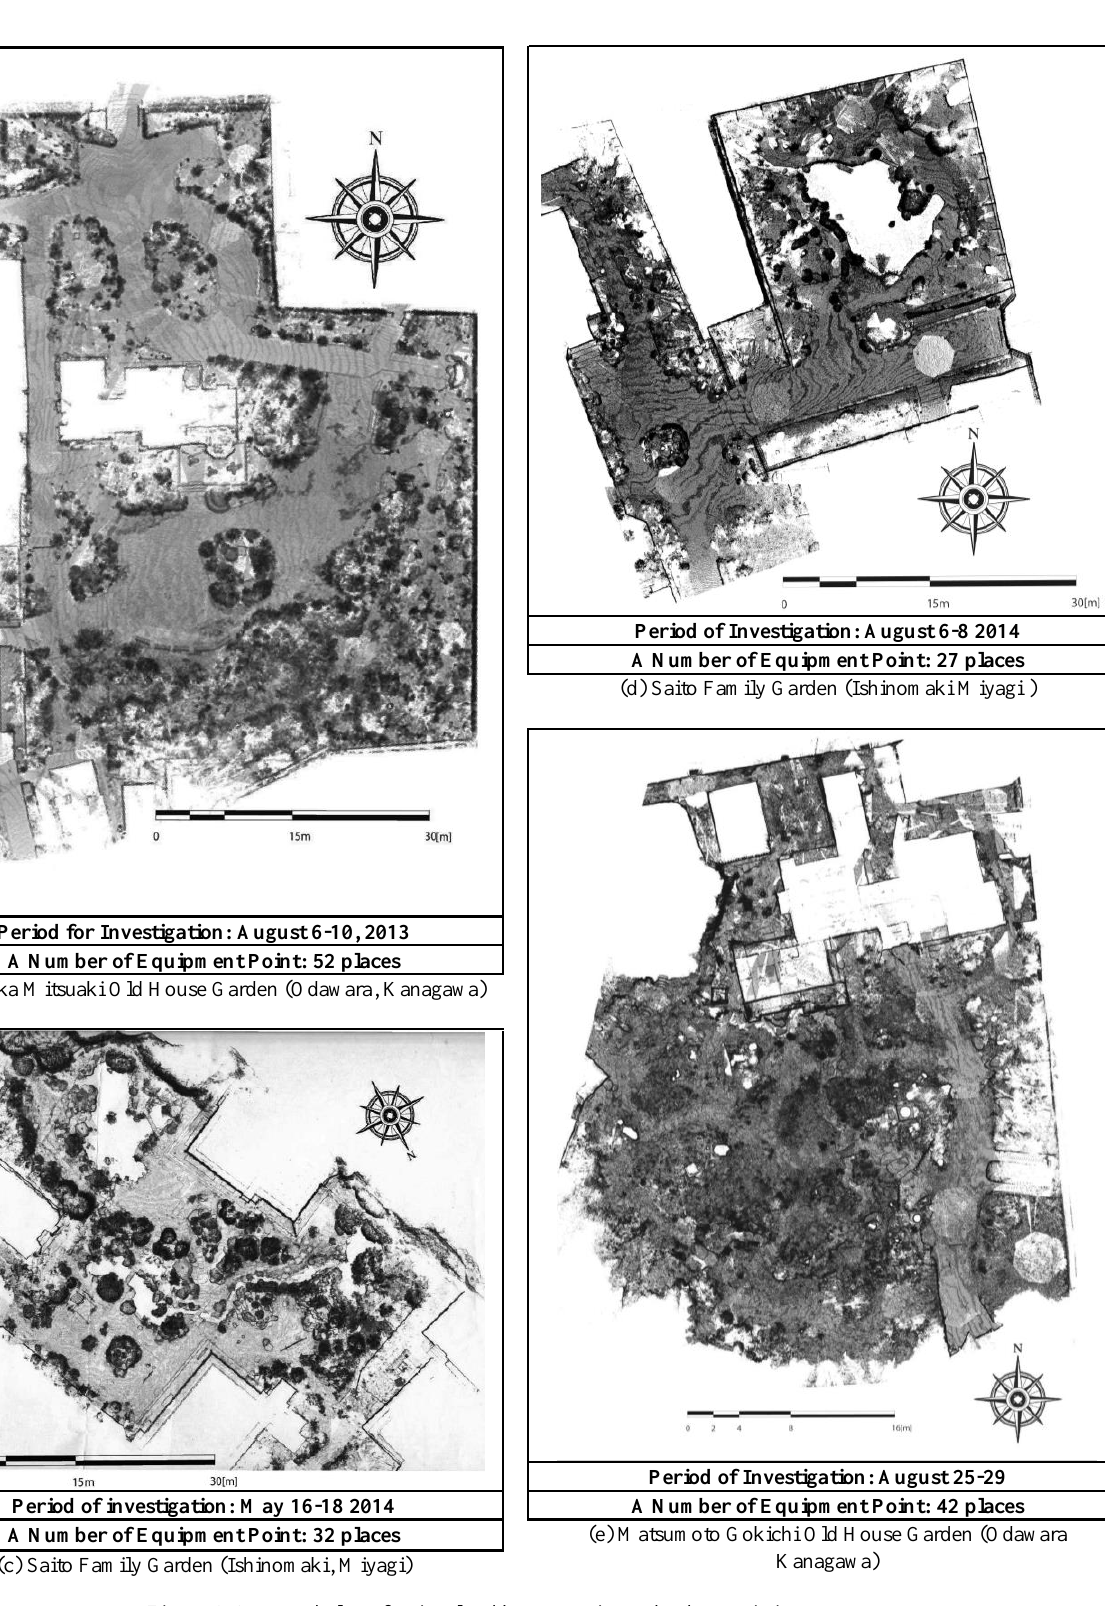
Figure 4. A ground plan of point cloud by outputting orthochromatic